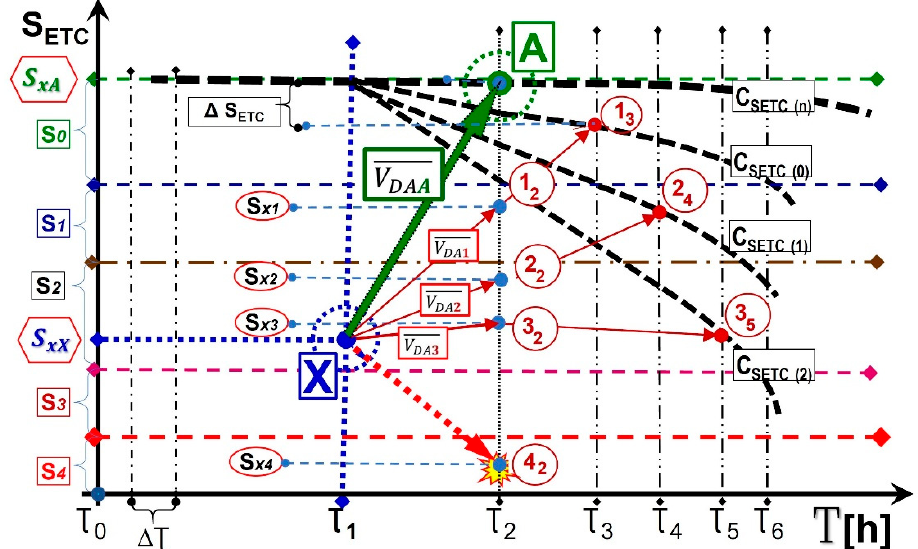
Figure 6. An overview drawing presenting graphically the vector concept of the decision accuracy vector V DA where: S ETC axis—the axis of the state of the engine’s technical condition; T axis—the axis of the engine’s lifetime; τ W axis—the axis of the relative lifetime of the engine; “ X ”—the point where values of the state of the engine’s technical condition have been assigned to the corresponding technical condition S x in time τ 1 ; “ A ”—the point where values of the state of the engine’s technical condition have been assigned to the corresponding technical condition S xA in time τ 2 ; V DAA —the decision accuracy vector in the area “ A ”; C STCP —curve of the state engine technical condition; C STCPn —curve of the state of the engine’s technical condition nominal (n), i.e., predicted during the design process (author’s own elaboration).